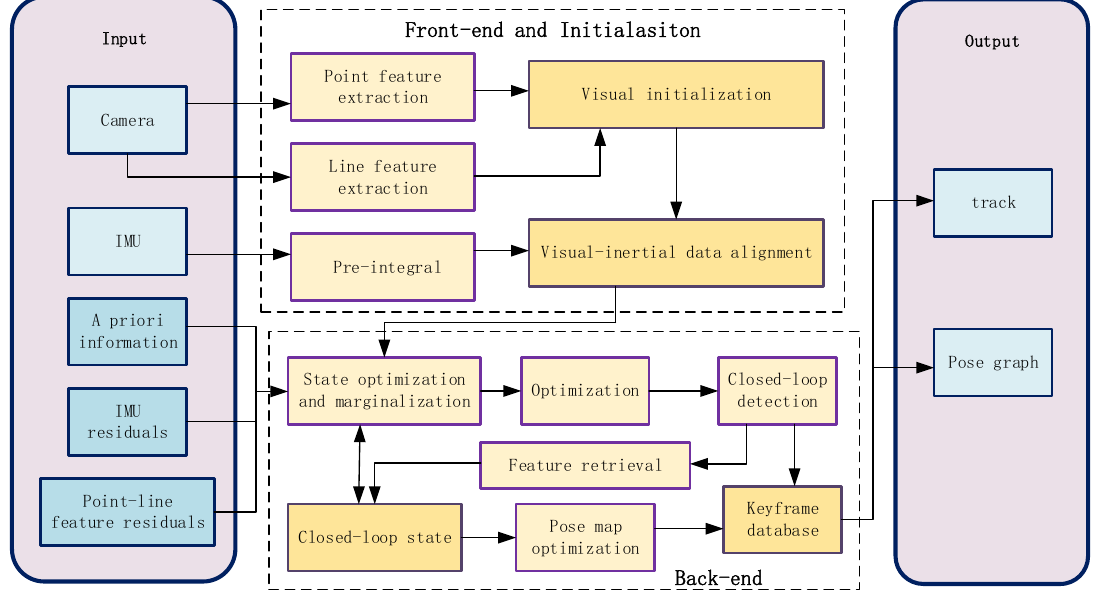
Figure 1. System block